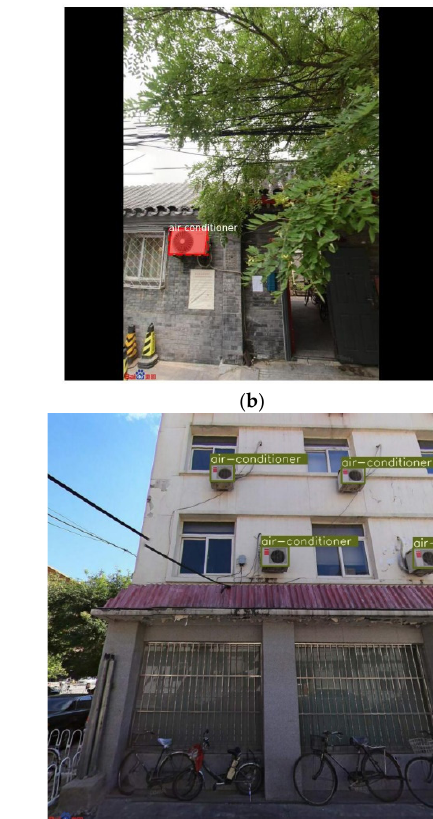
Figure 7. Several sample recognition result images using training model predictions by Mask-RCNN ( a , b ) and YOLOv5 ( c , d ) algorithms.